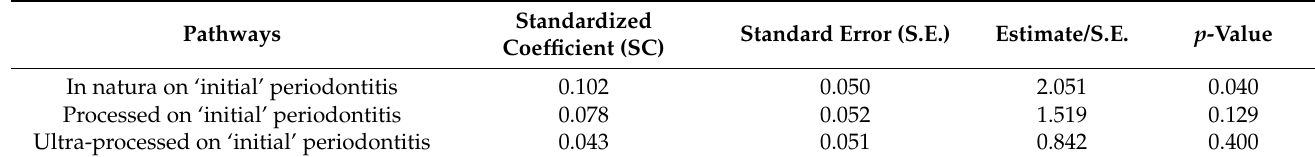
Table 2. Standardized effects of food consumption and initial periodontitis among adults enrolled in the 1982 Pelotas birth cohort.